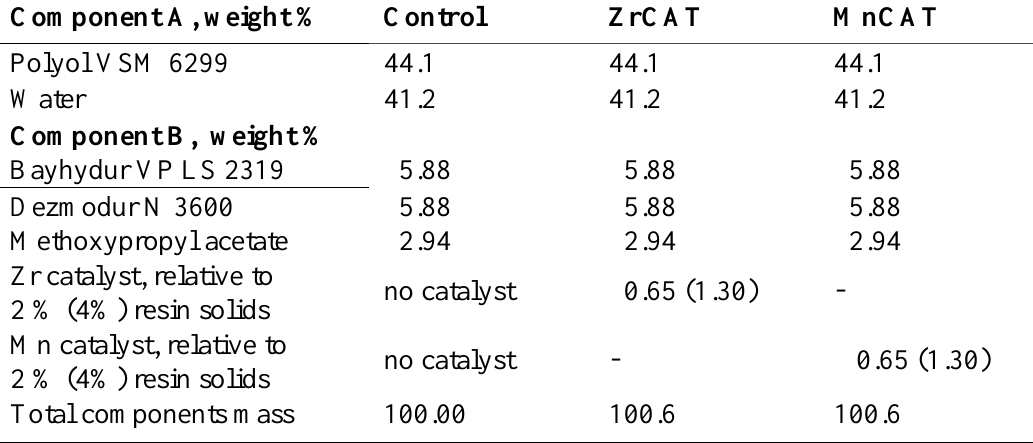
Table 1 . The composition of the two-component aqueous polyurethane sample (aqPUR1) based on the polyol component Macrynal VSM 6299 w/42 WA (coating hardness 32.5 %).